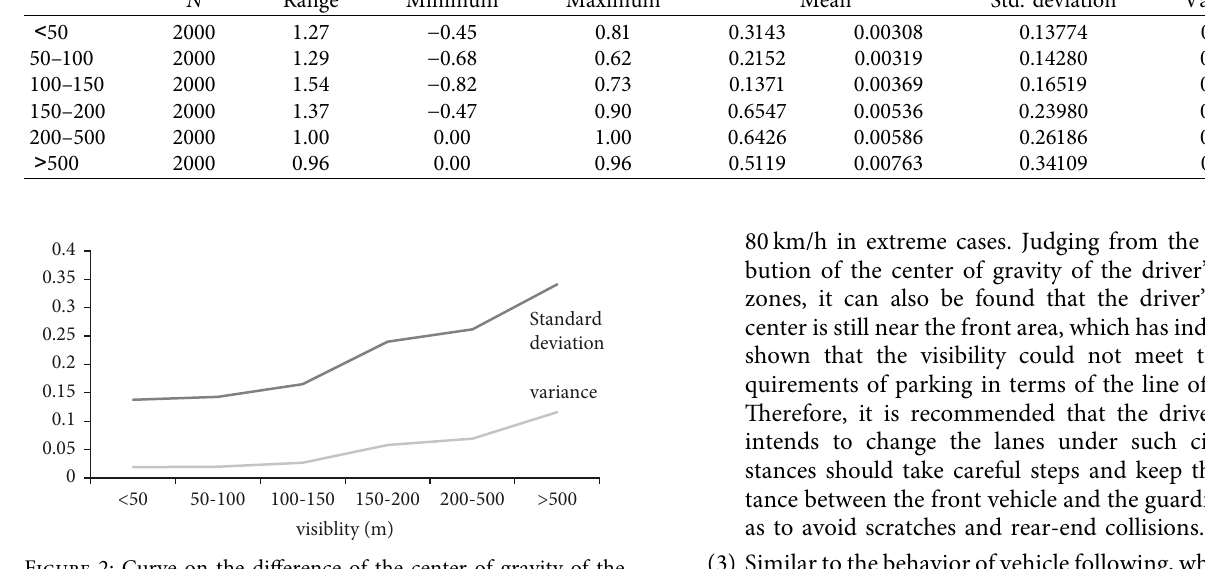
Table 1: Descriptive experimental results on the center of gravity of the driver’s visual gaze zone during the change of lanes. N